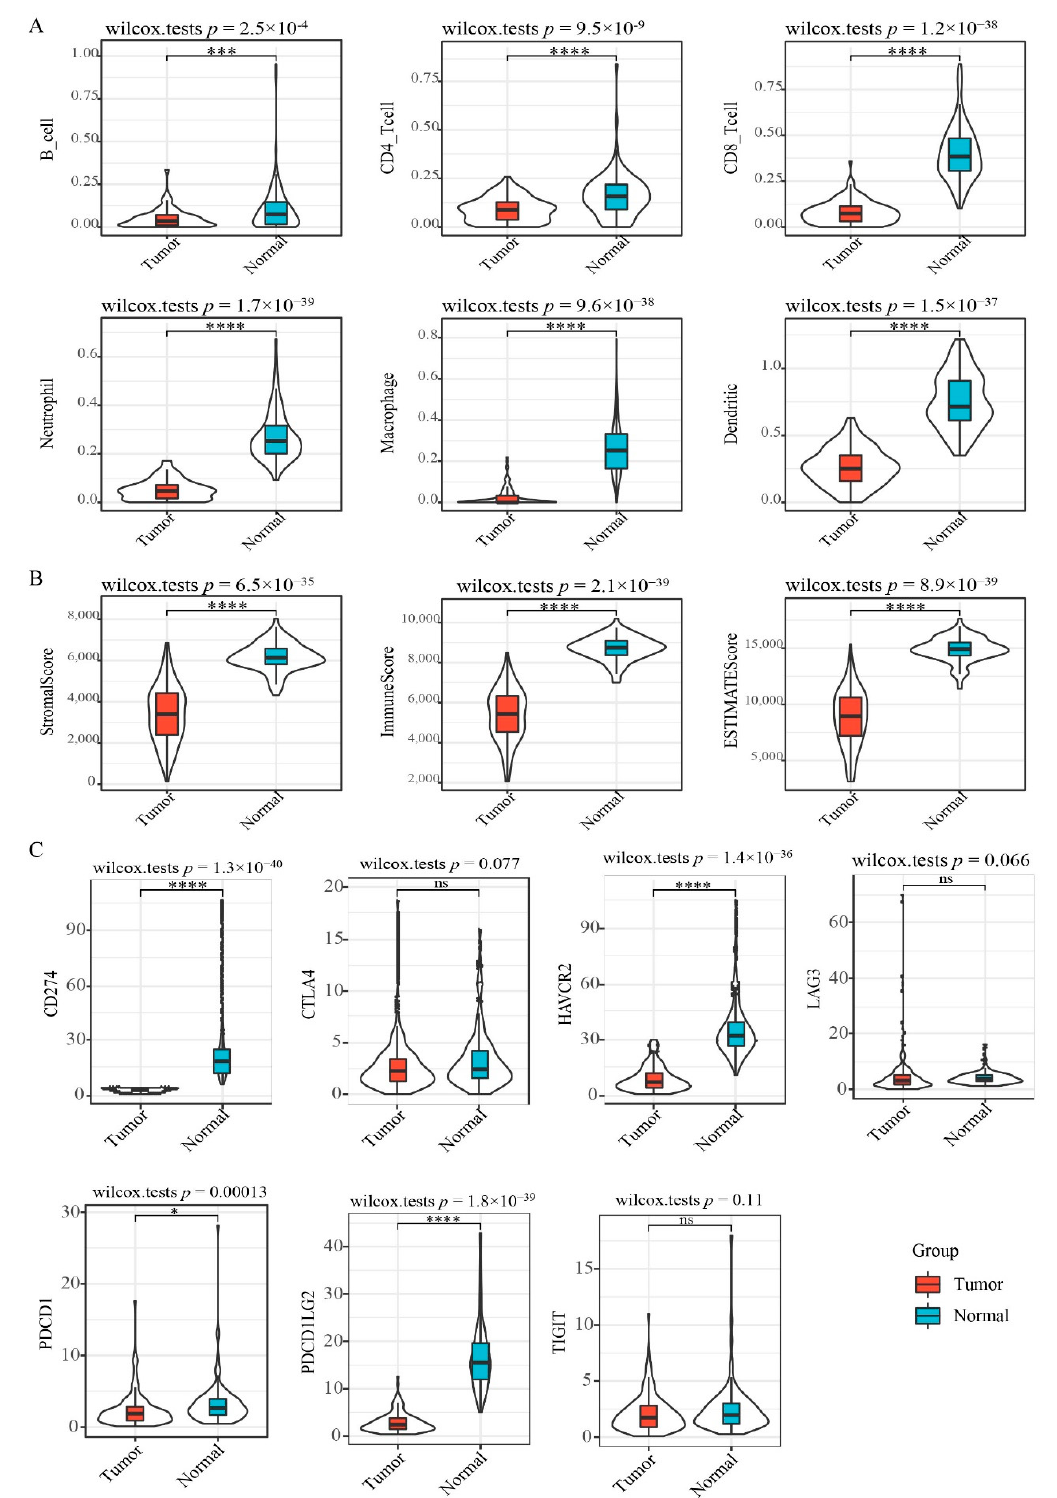
Figure 2. Immune signature scores in “EGFR Wild Type / Low PD-L1 expression” NSCLC. ( A ) The expression scores of immune-associated cells included in the TIMER algorithm. ( B ) The expression scores of genes included in the ESTIMATE algorithm for determination of stromal and immune gene signatures. ( C ) Differential expression of immune checkpoint molecules. Asterisks indicate significant differences (Wilcox test). * p < 0.05, ** p < 0.01, *** p < 0.001, **** p < 0.0001, ns means no significant.